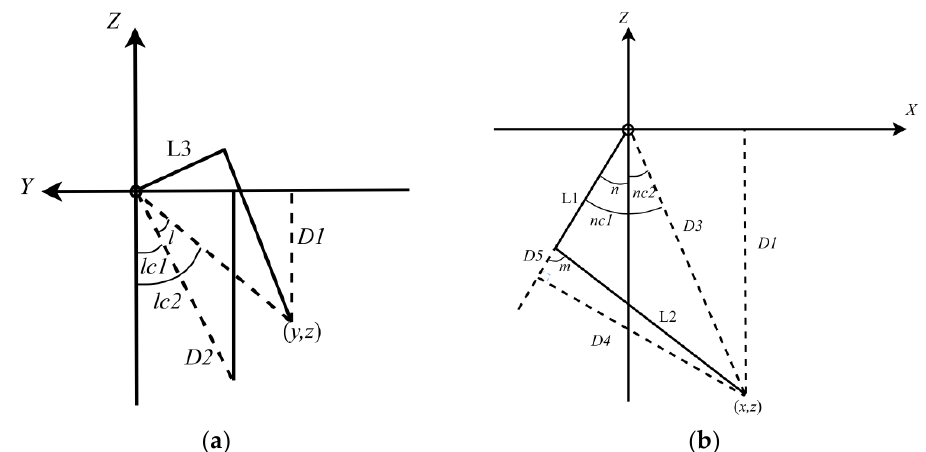
Figure 8. The position of robot legs. ( a ) in YZ plane and ( b ) in XZ plane, where D 1 is the projection of the leg in the plane Y-Z, D 2 is the shortest distance between the end and the start of the me- chanical arm, 𝑛𝑐1 is the angle between the thigh and the line, which connects the joint and foot, 𝑛𝑐 2 is the angle between Z-axis and the line which connects the joint and foot, and 𝑙𝑐1,𝑙𝑐2 are the angles between the quadruped robot and the z-axis before and after rotation.